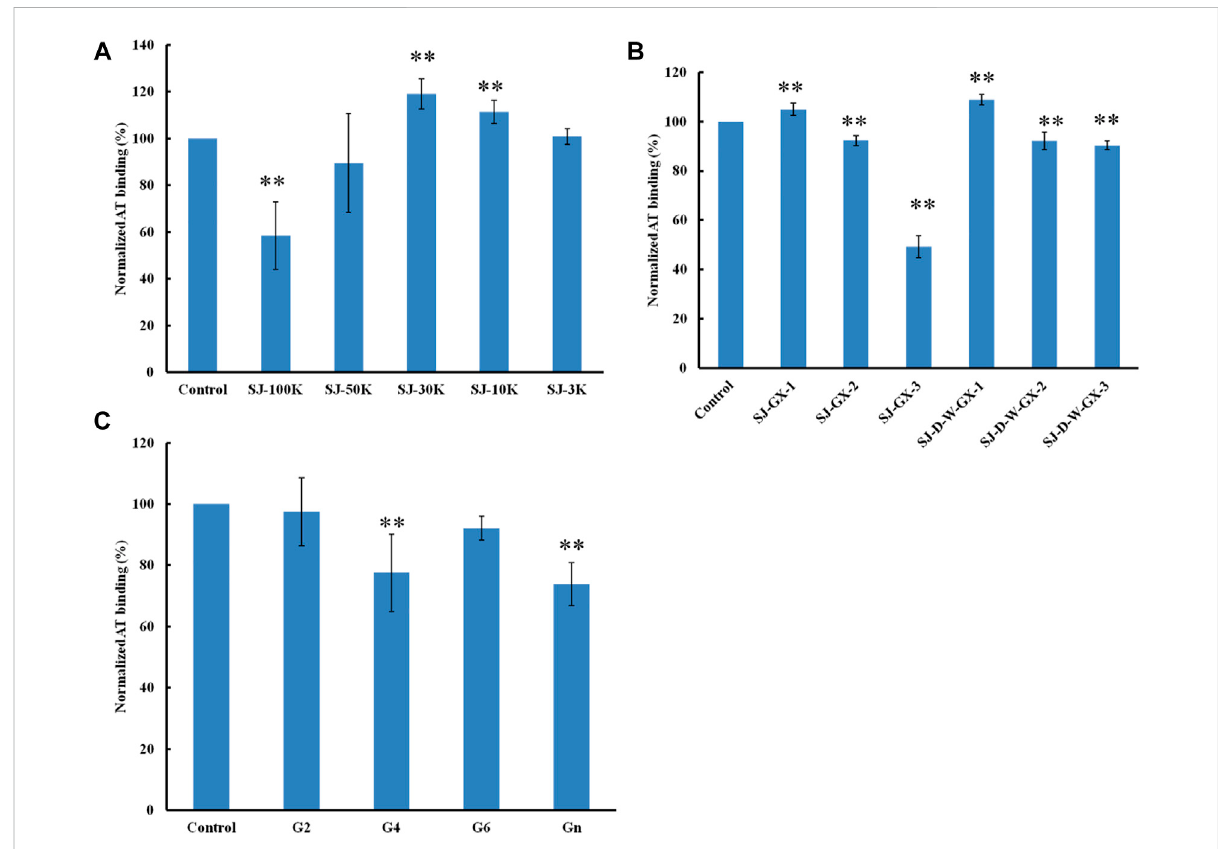
FIGURE 5 The binding abilities to AT (250 nM) premixed with different glycans (1 µM) on a heparin chip. (A) glycans derived from MWCO membranes; (B) fractions obtained from acid degradation; (C) glucuronomannan (Gn) and its oligomers. All the bar graphs with standard deviations were based on triplicate experiments. * p < 0.05, ** p < 0.01 compared with